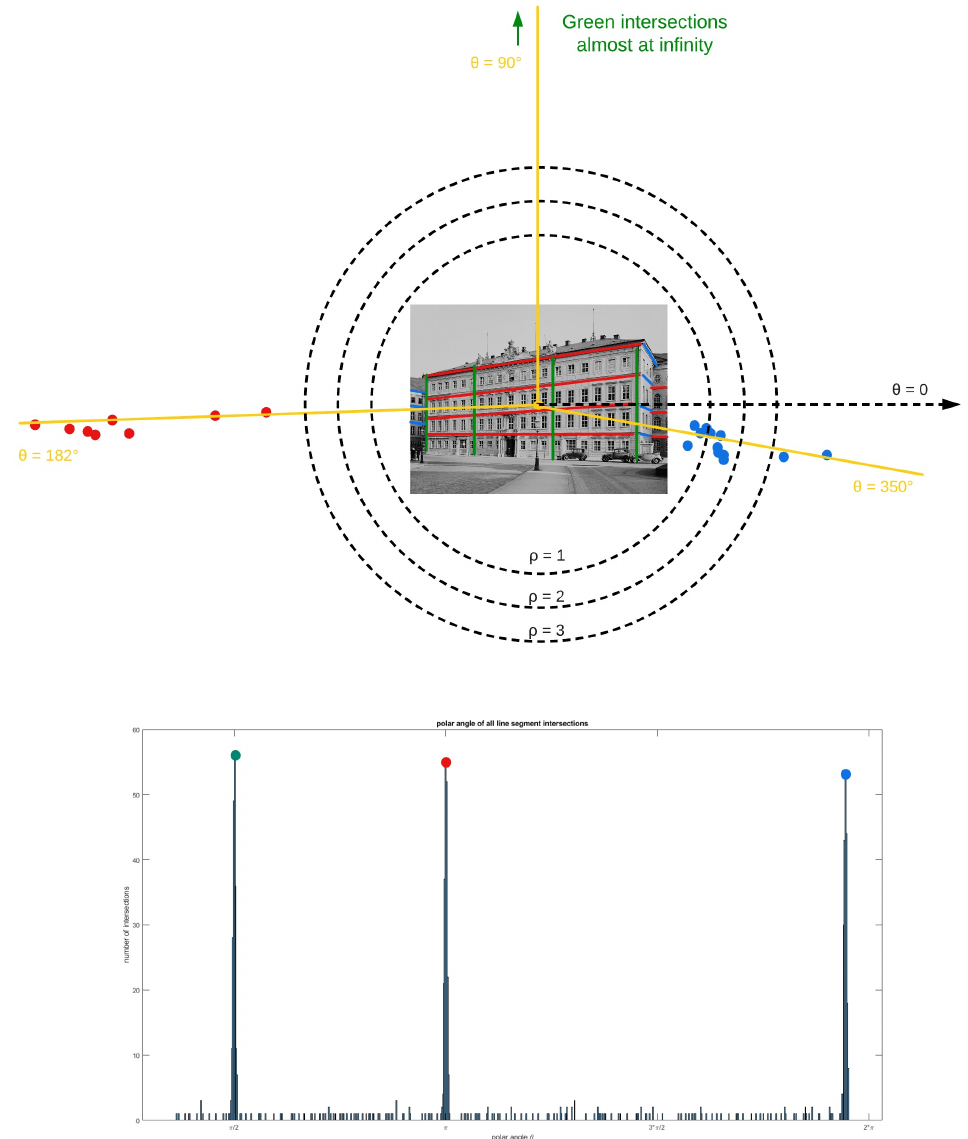
Figure 5. Schematic example of the principal distance estimation using VPs. Top: Example for the detected line segments with three main directions marked in blue, green, and red. Some selected line segment intersections are shown as colored dots. Bottom: Determination of the angle θ of three VPs using the distribution of all line segment intersections. The final angle θ is drawn as a line at the top of the